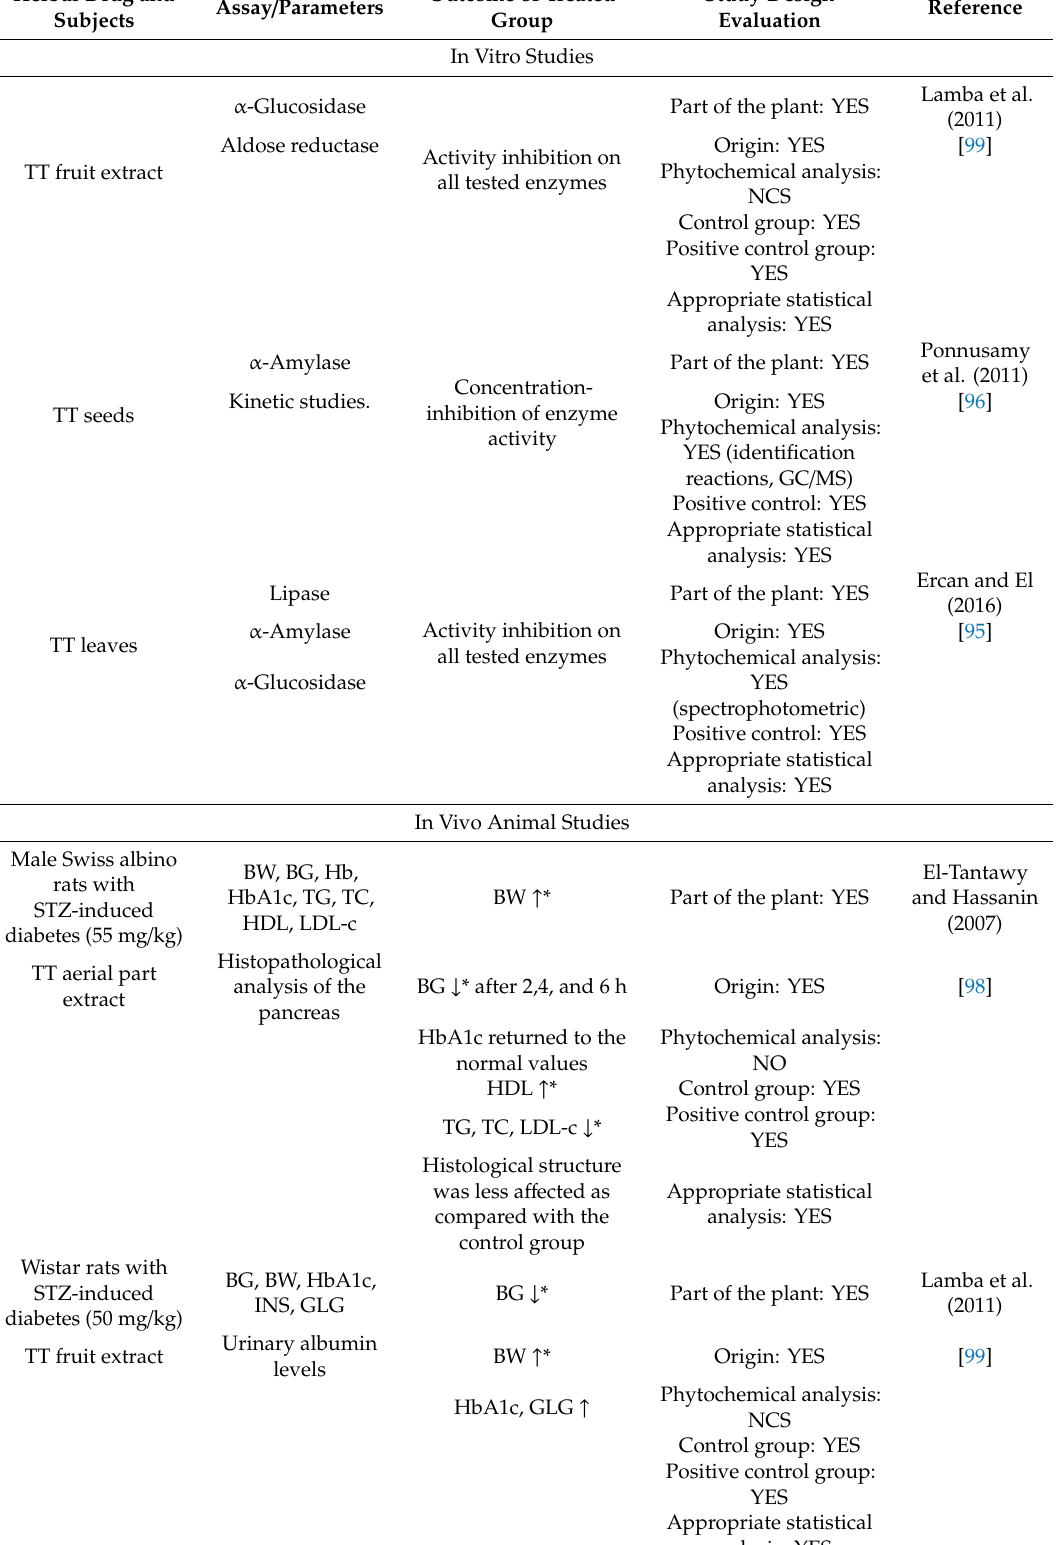
Table 4. In vitro and in vivo pharmacological studies and the study design evaluation. Herbal Drug